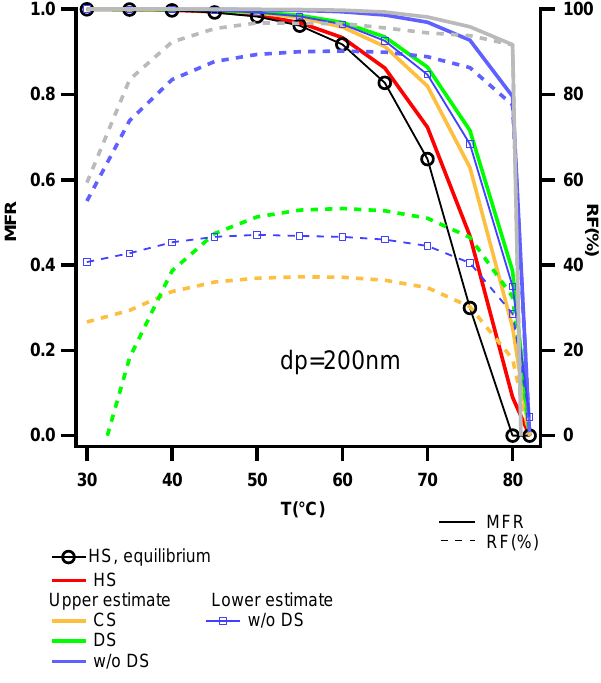
Fig. 6. Output thermograms and recondensation fraction for the heating section (HS), cooling section (CS), denuder section (DS) and equivalent configuration without denuder section (w/o DS),in a system with 200nm aerosol particle size at 400µgm − 3 aerosol loading. Comparison of this plot with Fig. 5 at γ 0 =1 ( d p =100nm) indicates a deceleration in the re-condensation process for increas- ing particle size, at constant aerosol loading. This is a result of a re- duction in the particle number available, which leads to slower evap- oration and re-condensation rates. Baseline case: C ∗ =0.1µgm − 3 , γ 0 =1 and D i =5e–6cm 2 s − 1 . Upper estimate: upper estimate for re-condensation (no mass transfer to walls); lower estimate: lower estimate for re-condensation (equilibrium wall